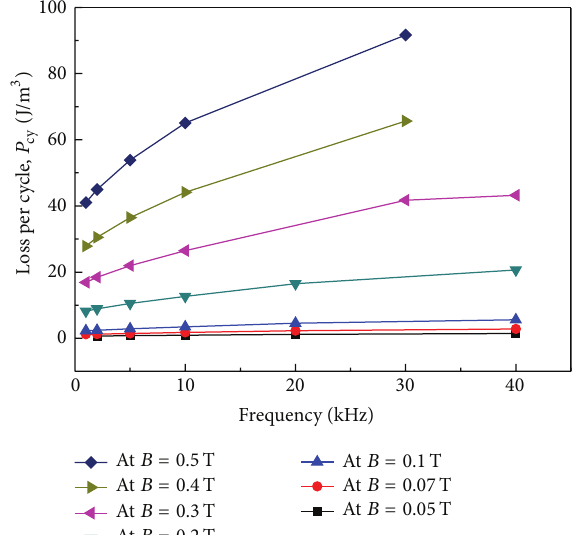
Figure11:Variationoflosspercycle( 𝑃 𝐵